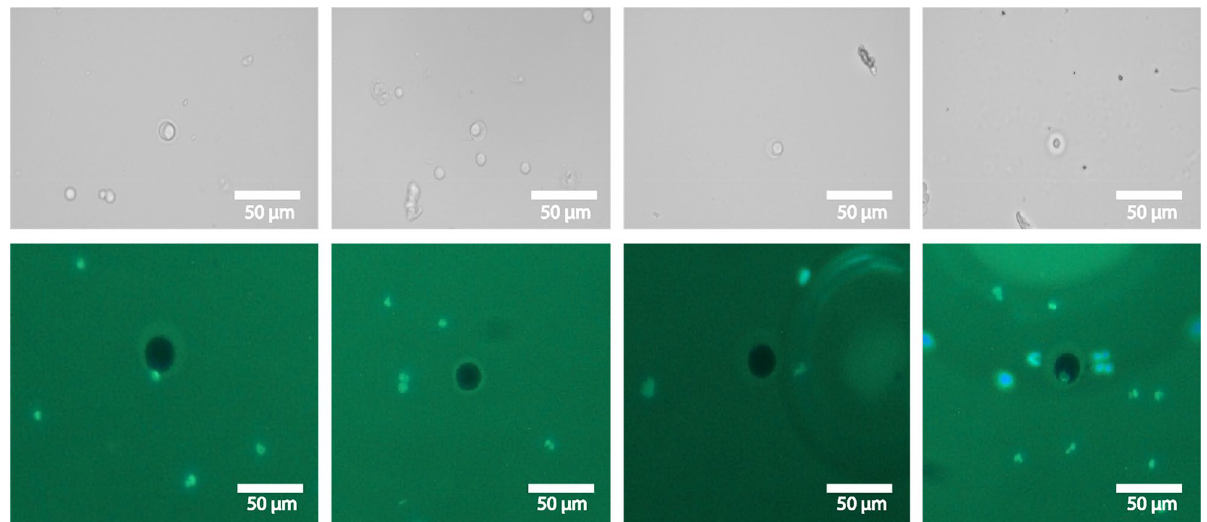
Figure 7. Images in the bright-field microscopy and fluorescence microscopy datasets. It turned out that there was an issue with the contrast because of which the artifacts were not observable. Later, we resorted to fluorescence microscopy images (bottom), where each artifact was distinctive and observable.